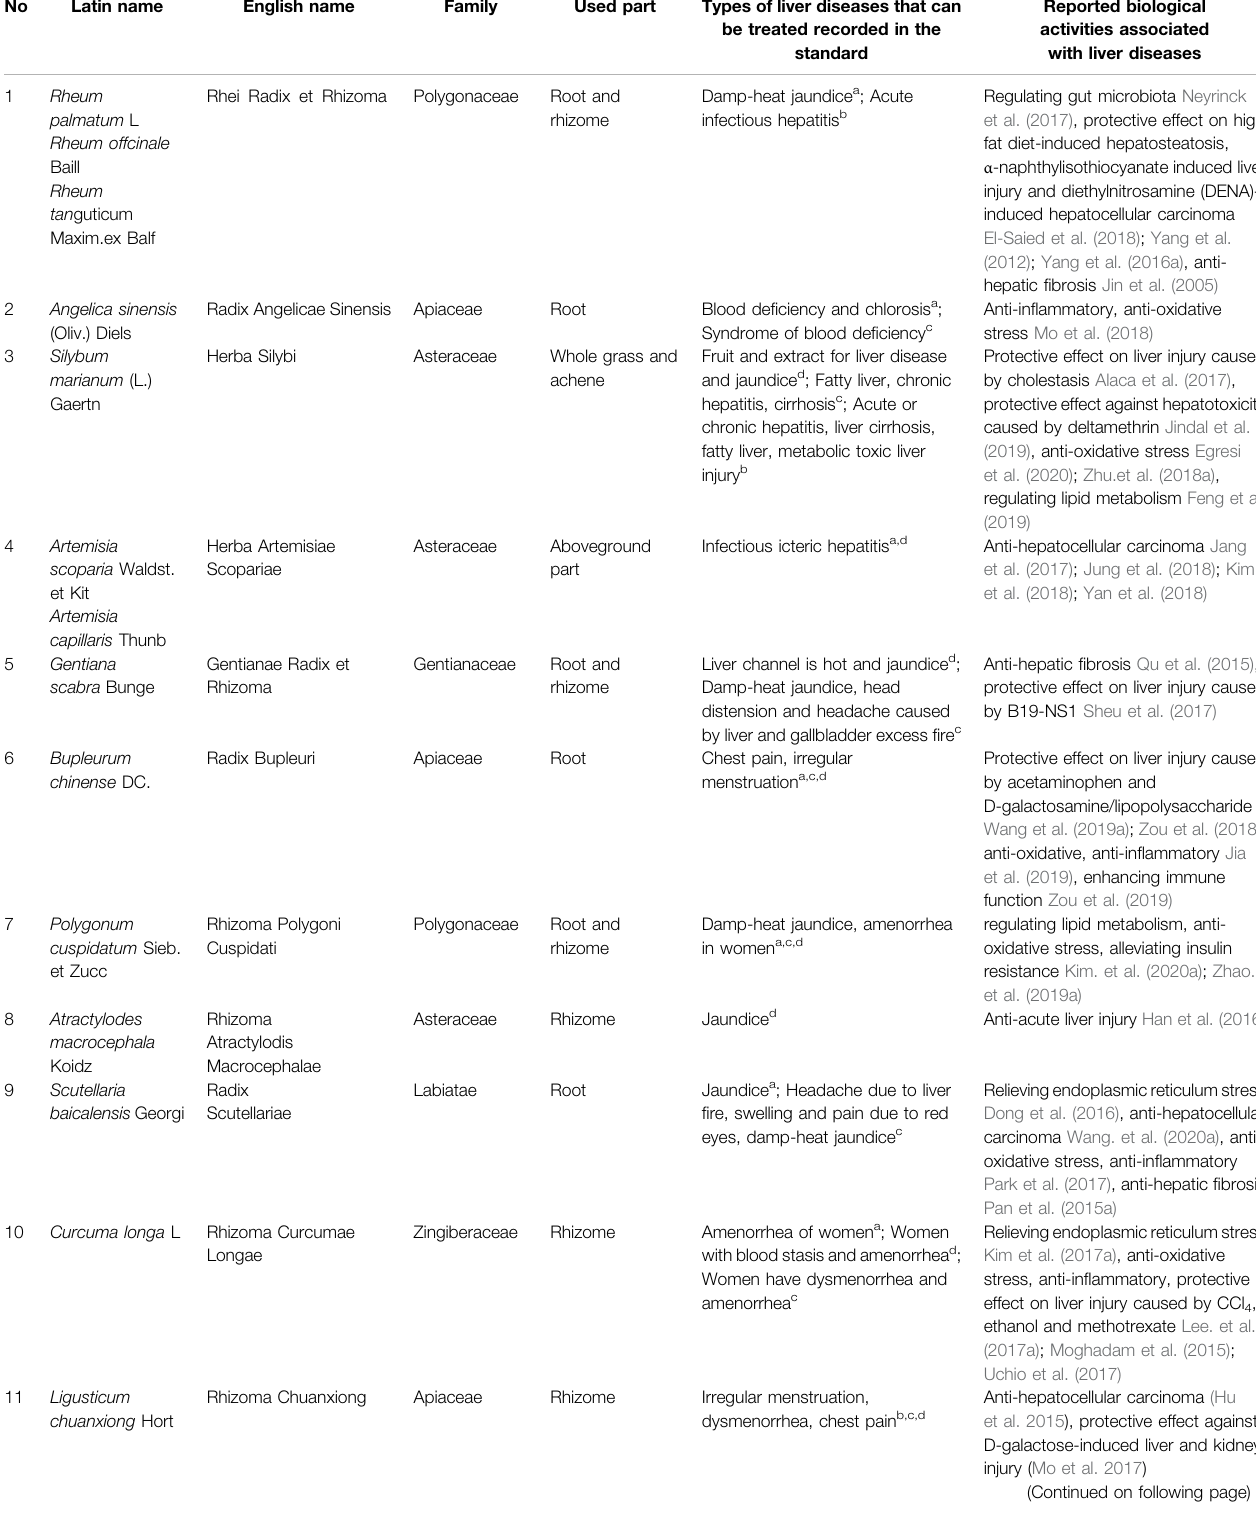
TABLE 1 | Some of the Chinese medicine used for the treatment of liver diseases are described in the standard and their biological